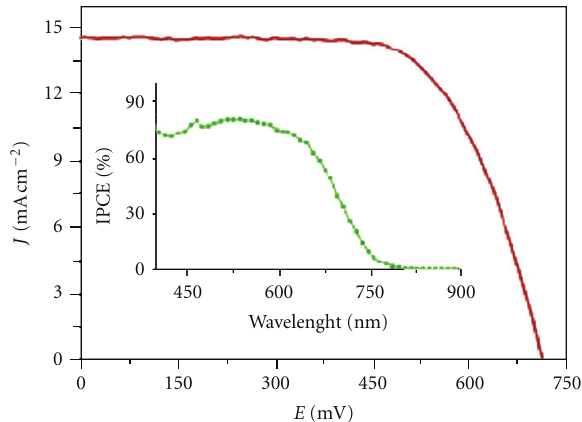
Figure 8: Photocurrent density-voltage characteristics under AM 1.5 full sunlight (100 mWcm − 2 ) (taken from